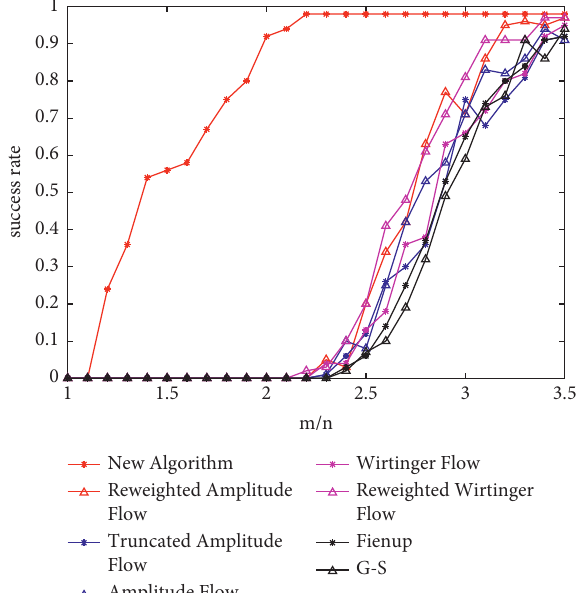
Figure 3: Success rates for algorithms at a fixed sparsity level and the length of an unknown vector.